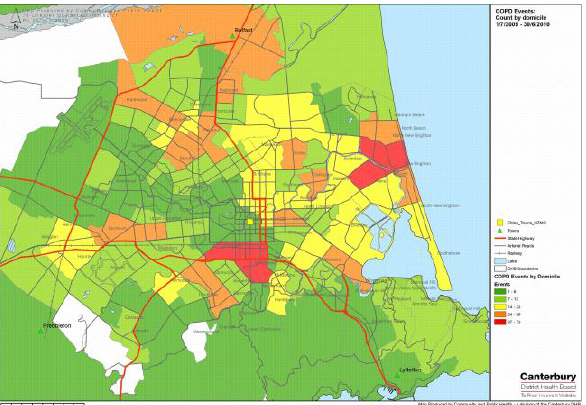
Figure 3. COPD admission events in Christchurch (NZ) (CDHB,